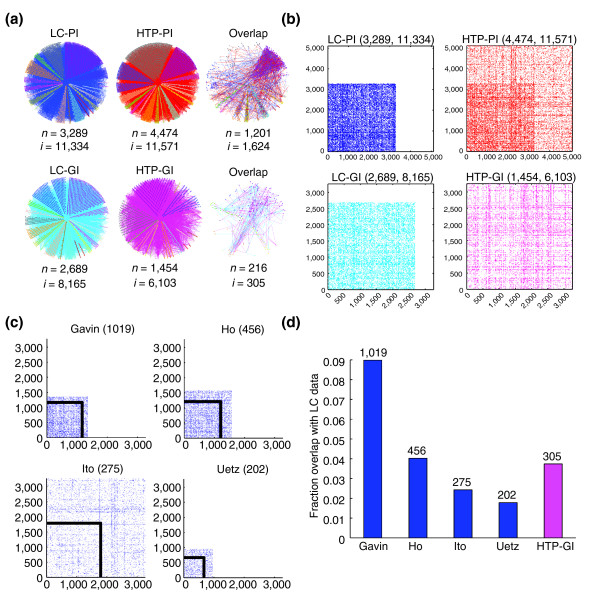
Intersection of LC and HTP datasets. (a) Datasets were rendered with the Osprey visualization system [65] to show overlap between indicated LC and HTP datasets. n, number of nodes; i, number of interactions. (b) Coverage in the HTP physical interaction dataset (collated from five major HTP studies: Uetz et al. [5], Ito et al. [6], Ito et al. [7], Gavin et al. [9], Ho et al. [8]) overlaps strongly with coverage in the LC dataset. Proteins present only in the LC dataset were labeled first, followed by proteins present only in the individual HTP datasets. In all plots, a dot represents interaction between proteins on the x- and y-axes. As the networks are undirected, plots are symmetric about the x = y line. Self interactions were removed. (c) Overlap of individual HTP datasets with the LC dataset. Dot plots show all interactions from each HTP dataset partitioned according to proteins that are present in the LC-PI dataset (inside the boxed region) and those that are not (outside the boxed region). 'Ito' indicates data from Ito et al. [7] rather than Ito et al. [7]. The protein content is different for each dataset and so ordinates are not superimposable. The number of overlapping interactions between each HTP dataset and the LC dataset is shown in parentheses. Note that only a small fraction of interactions in each boxed region actually overlaps with the LC-PI dataset because of the high false-negative rate in HTP data. (d) The number of LC interactions in HTP datasets.